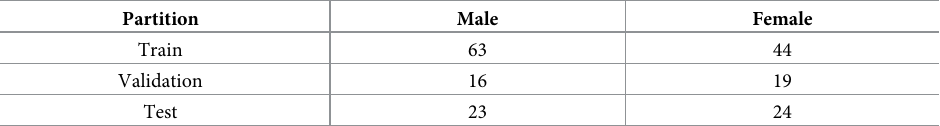
Table 1. Distribution of male and female participants across train, validation and test partitions of the DAIC-- WOZ depression